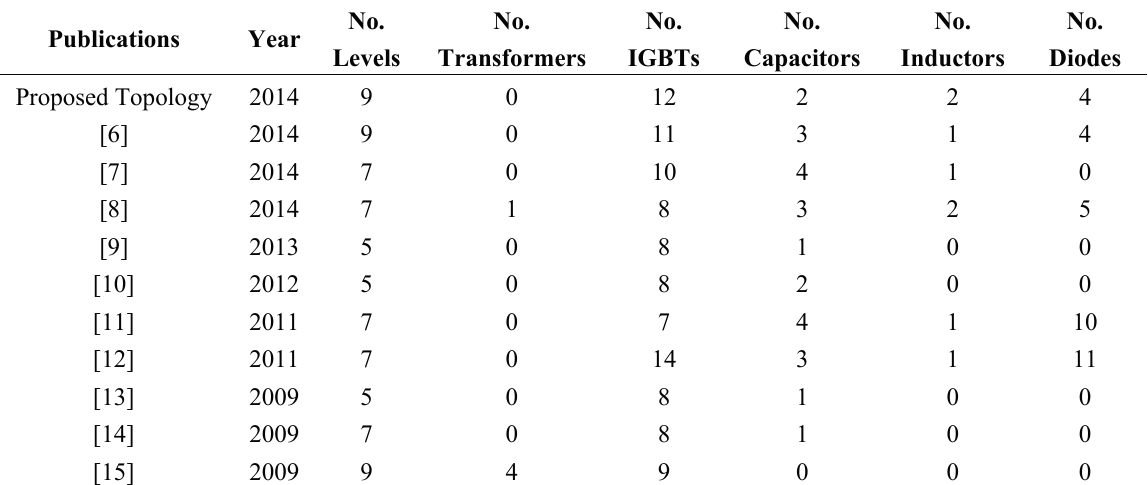
No. No. No. No. No. No. Levels Transformers IGBTs Capacitors Inductors Diodes